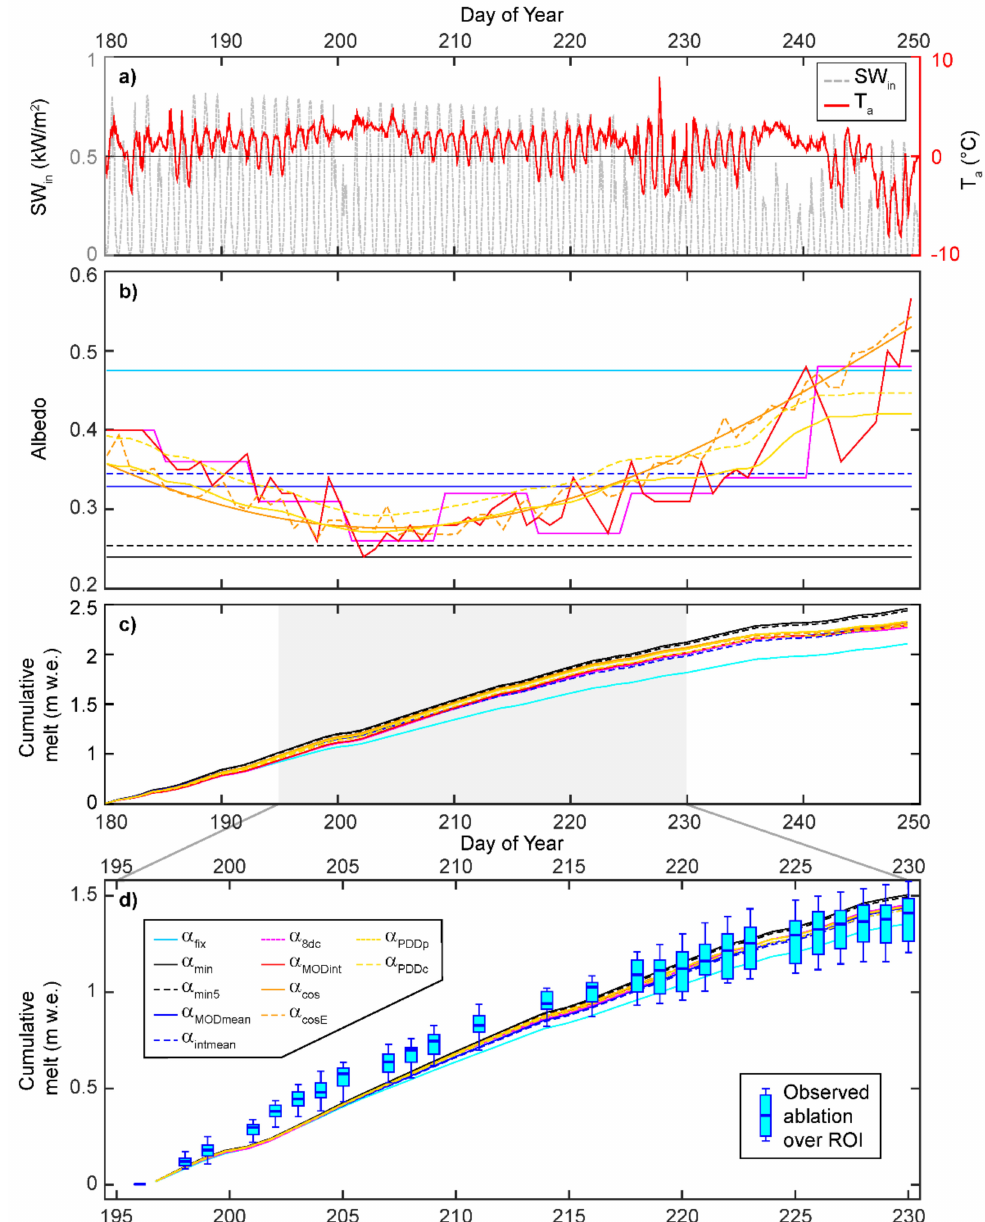
Figure 5. ( a ) Irradiance (SW in ) and air temperature (T a ) records at S6 for the JJA melt season in 2016. ( b ) Time-series of daily albedo parameterizations for the same summer period (cf. Table 1). ( c ) Modelled cumulative ice ablation using the varied albedo descriptors in ( b ) for JJA. ( d ) Comparison between model realizations and observed cumulative ablation recorded over 12 locations within the ROI at daily time-steps; observed cumulative ablation at daily time-steps shown as median with 25–75% quartile and full data range. Key for ( b – d ) shown in ( d